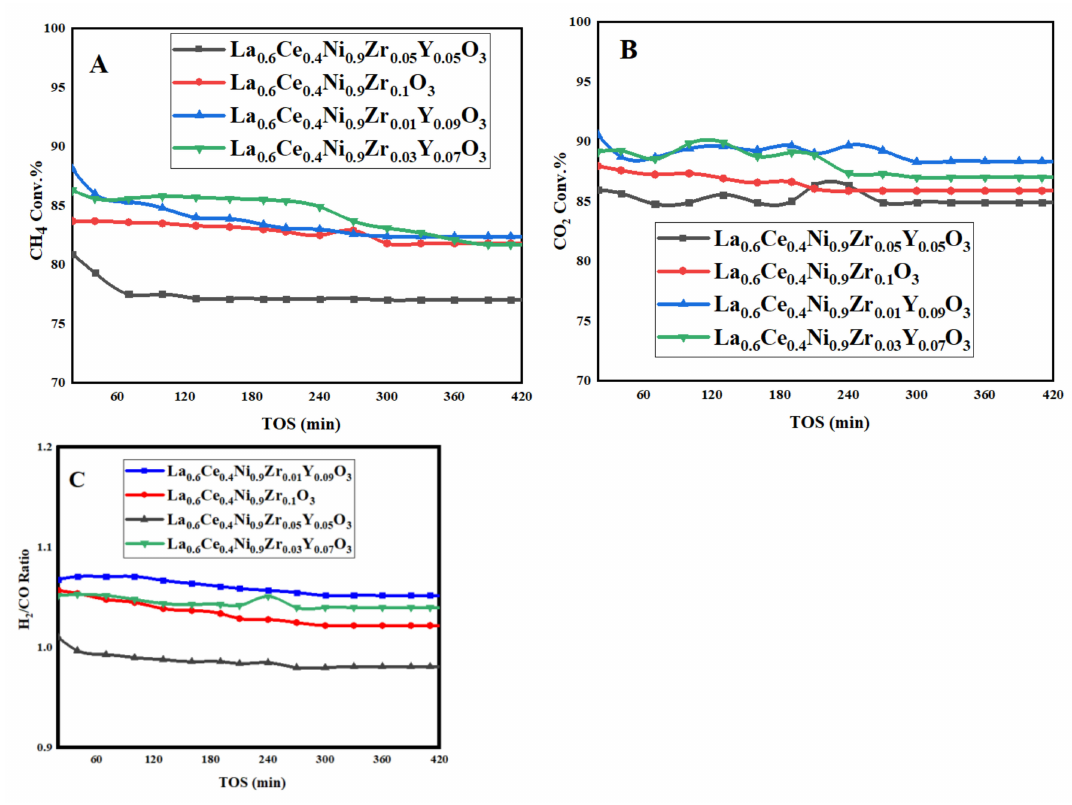
Figure 12. ( A ) CH 4 conversion; ( B ) CO 2 conversion; ( C ) H 2 /CO ratio of cata-